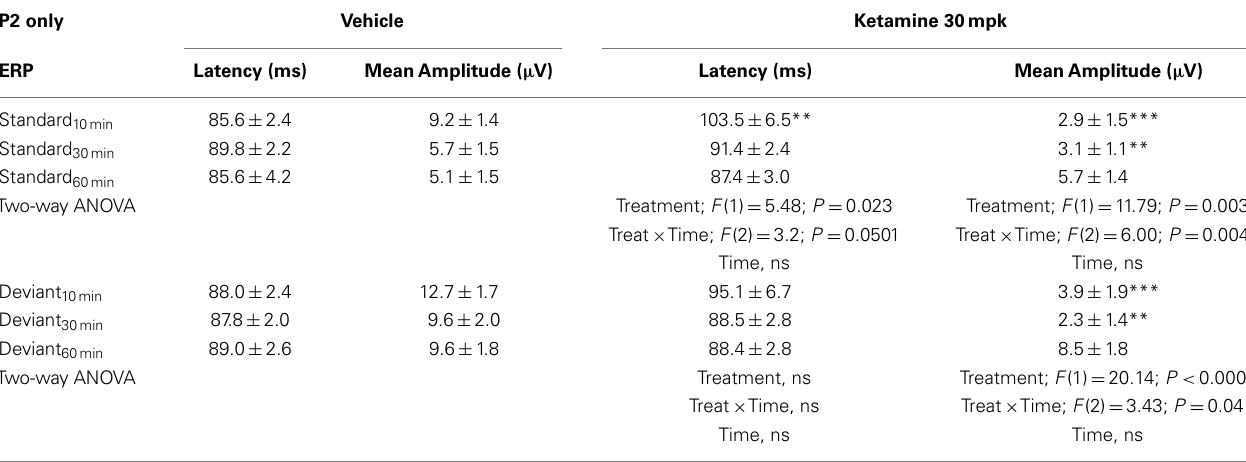
Table 3 | N2 component latency and amplitude tabulated as standard and deviant across vehicle and ketamine treatments .